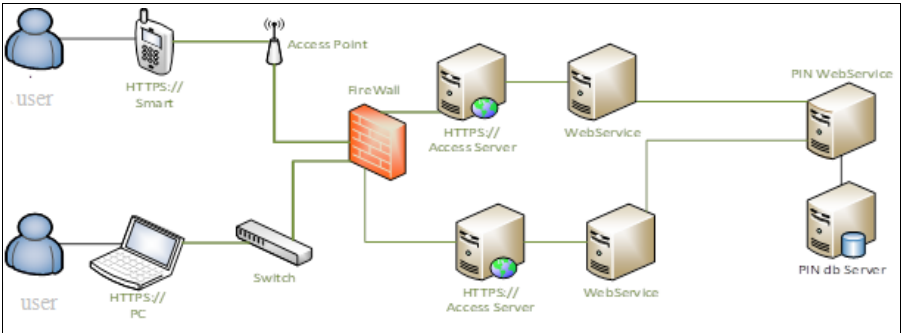
Figure 2. Use of systems published on the Internet using systems with HTTPS security protocols